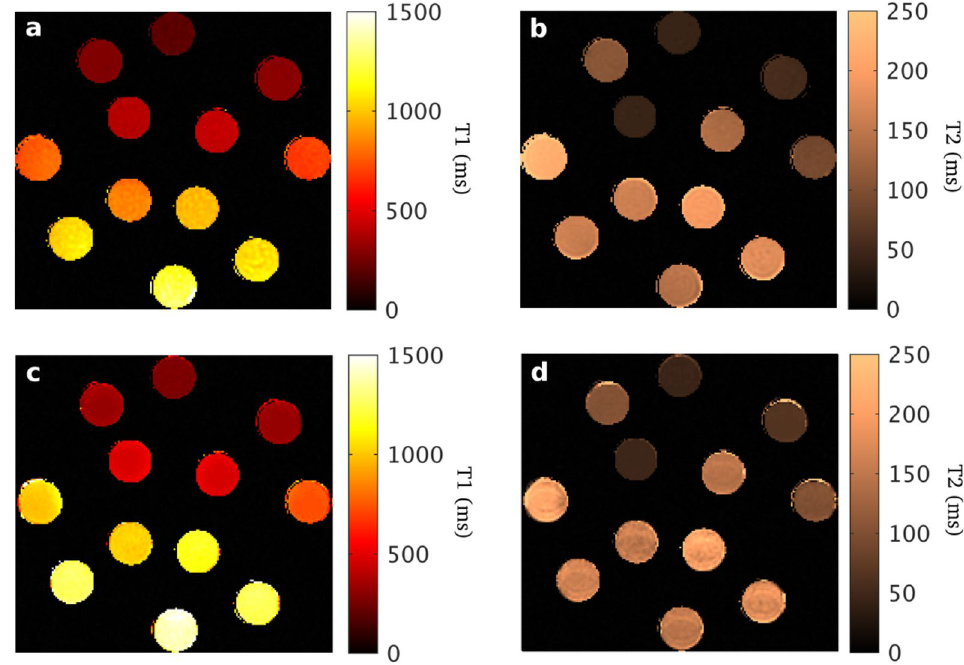
Figure 6. The first row shows the maps from the proposed balanced pulse sequence for the propagator as a composite of pulses according to the “ α x − γ y − α y − γ x ” MP-b-nSSFP scheme ( α = 90 ; γ = 175 ) . The second row show maps obtained using conventional MAGIC. (a,c) T1 maps. (b,d) T2 maps.